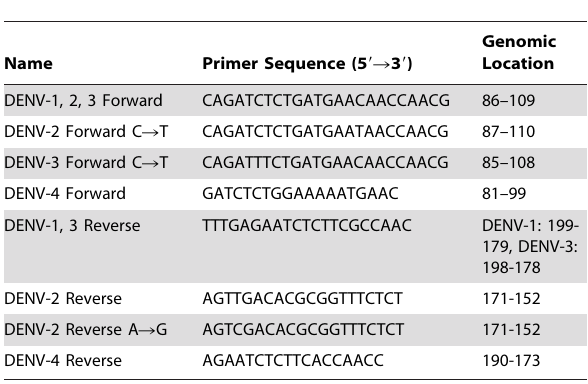
Table 1. Primer sequences for the DENV multiplex rRT-PCR.